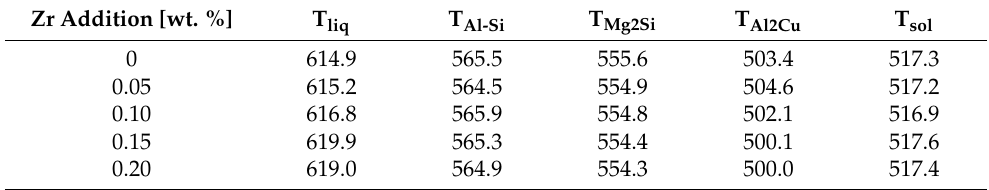
Table 4. Characteristic solidification temperatures of the AlSi5Cu2MgZrX alloys.